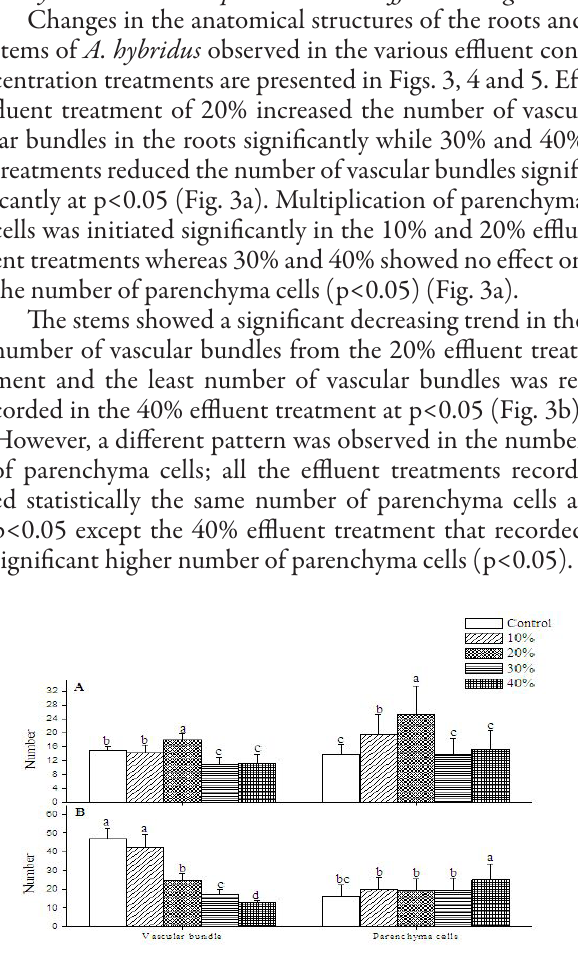
Fig. 3. Variation in the effects of various concentrations of phar- maceutical effluents on tissue components of (a) root and (b) stem of A.